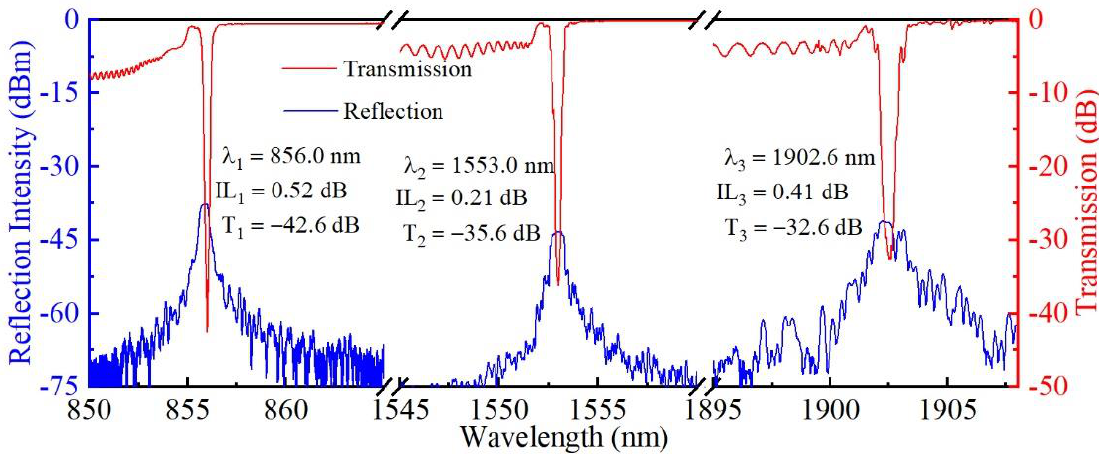
Figure 6. Transmission and reflection spectra of three inscribed FBGs with various Bragg wave- lengths.